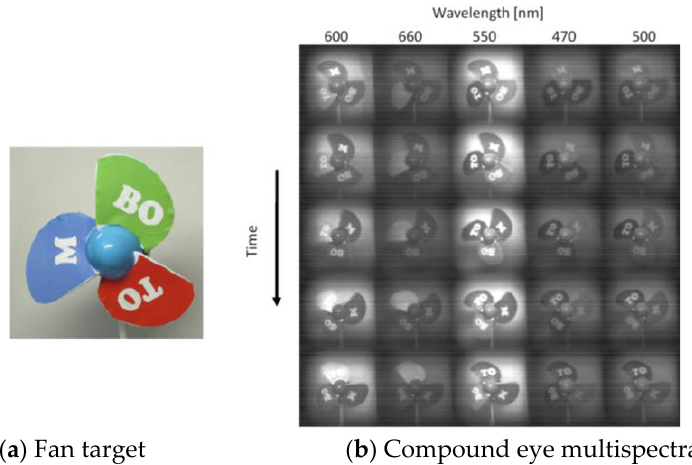
Figure 20. High-speed MSI: ( a ) a fan and ( b ) captured compound-eye image with the fan rotating in a clockwise direction. The effective frame rate is approximately 100 fps.